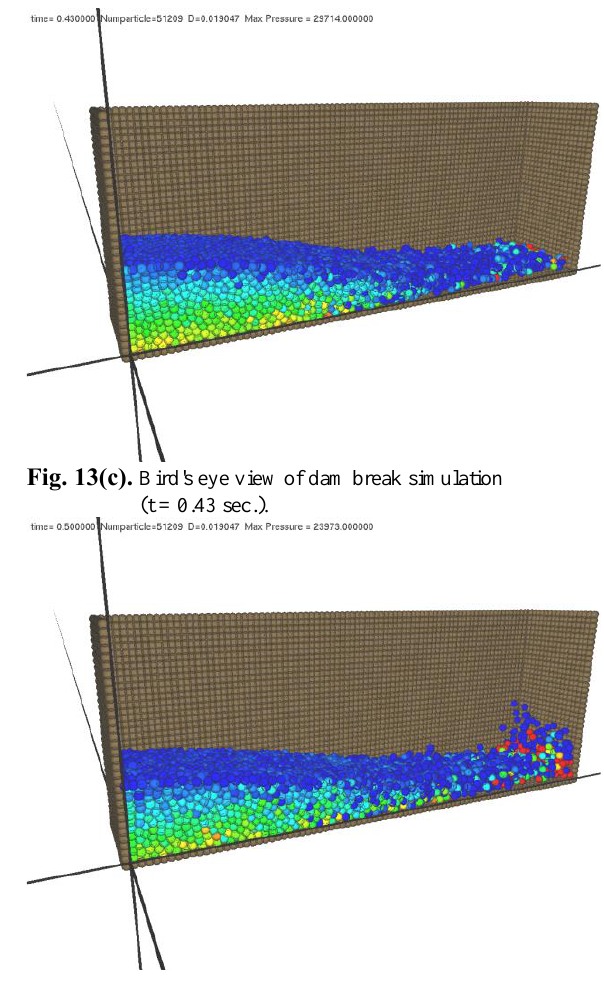
Fig. 13(d). Bird's eye view of dam break simulation (t = 0.50 sec.) .